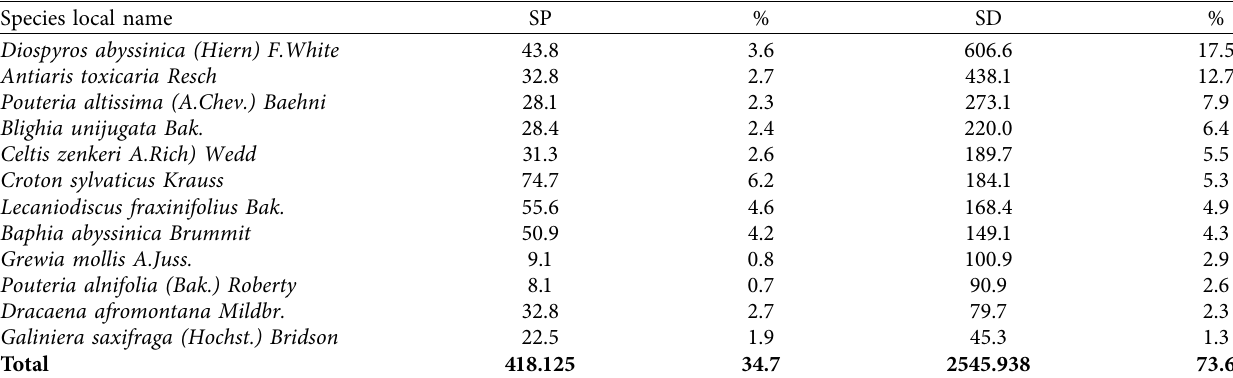
Table 10: List of top 12 species regeneration status in all sites.